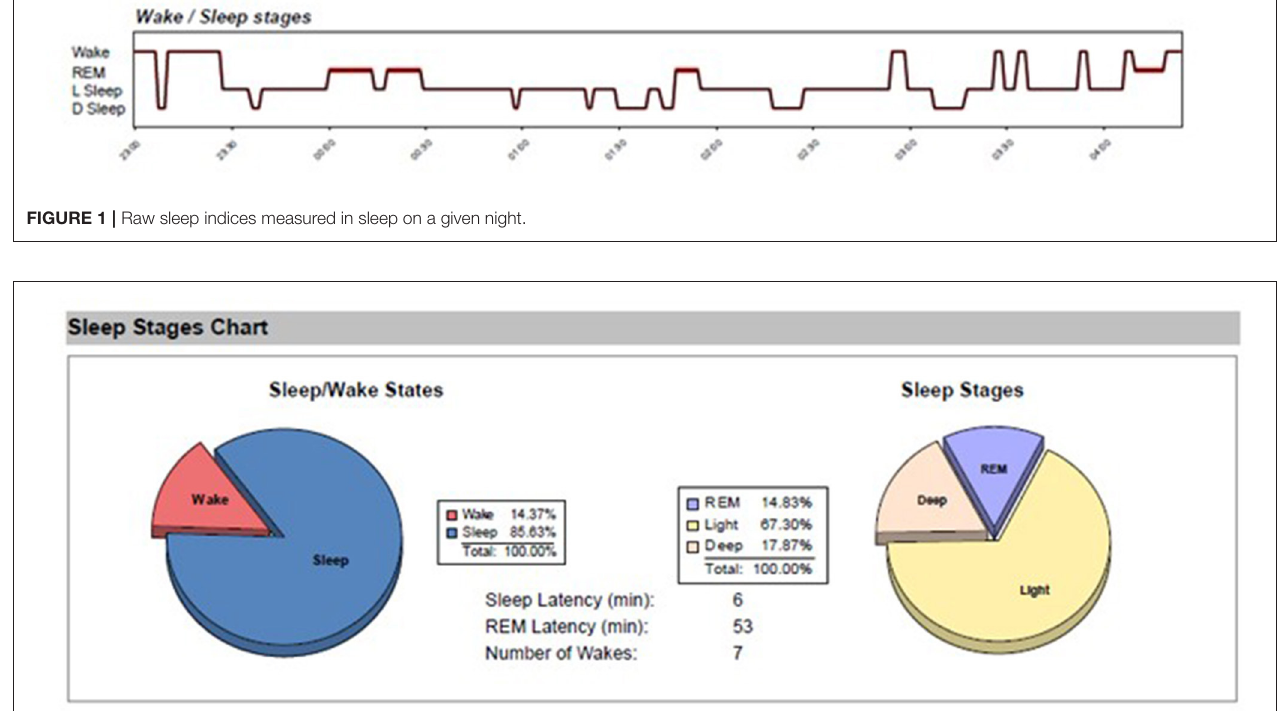
FIGURE 2 | Sleep stages chart on a given night.